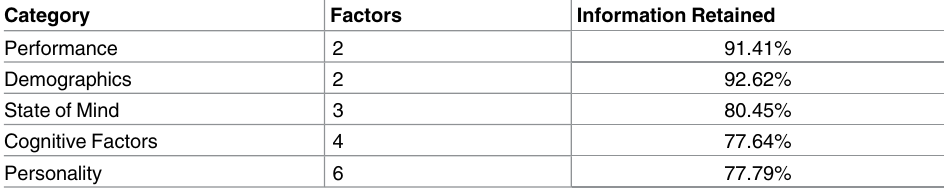
Table 1. Information retained for multi-task study. Categories, number of factors for each, and how much overallvariancefrom the multi-task individualdifferencedata was retainedfor each category. Each cat- egory represents a subset of the 42 individualdifference measures and the factors represent a percentageof the variance containedin the category for the multi-task data.